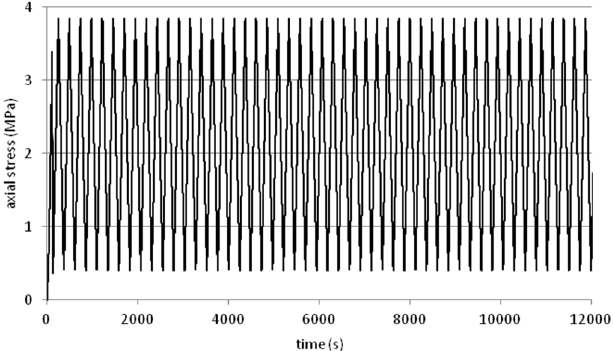
Figure 10. Plot of axial stress over time from cCBR tests (unsoaked conditions).